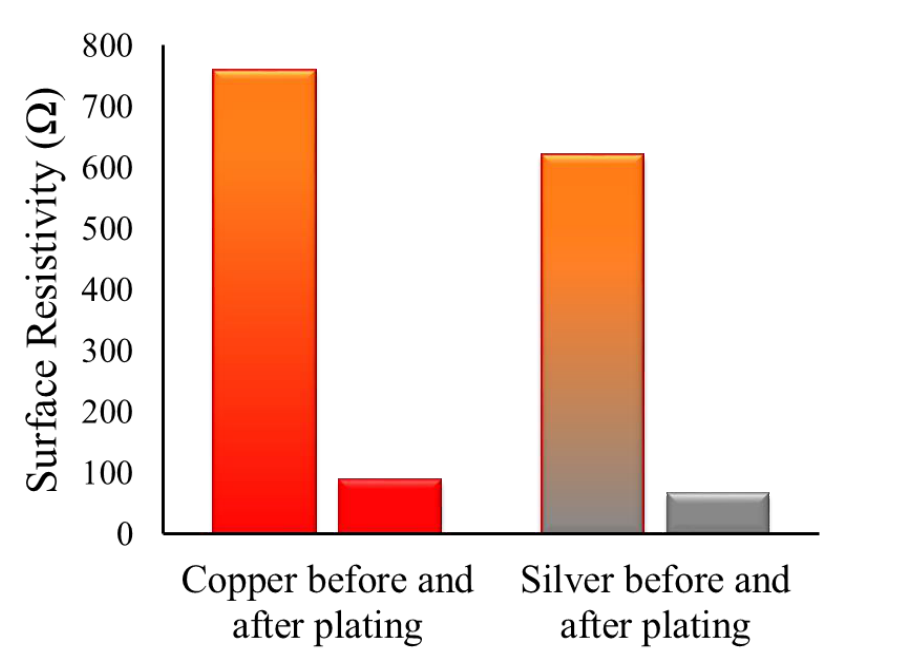
Figure 7. Reduction in electrical resistivity before and after electroplating. Table 2. Resistivity values of conductive fabrics against concentrations of copper salt. Sr.